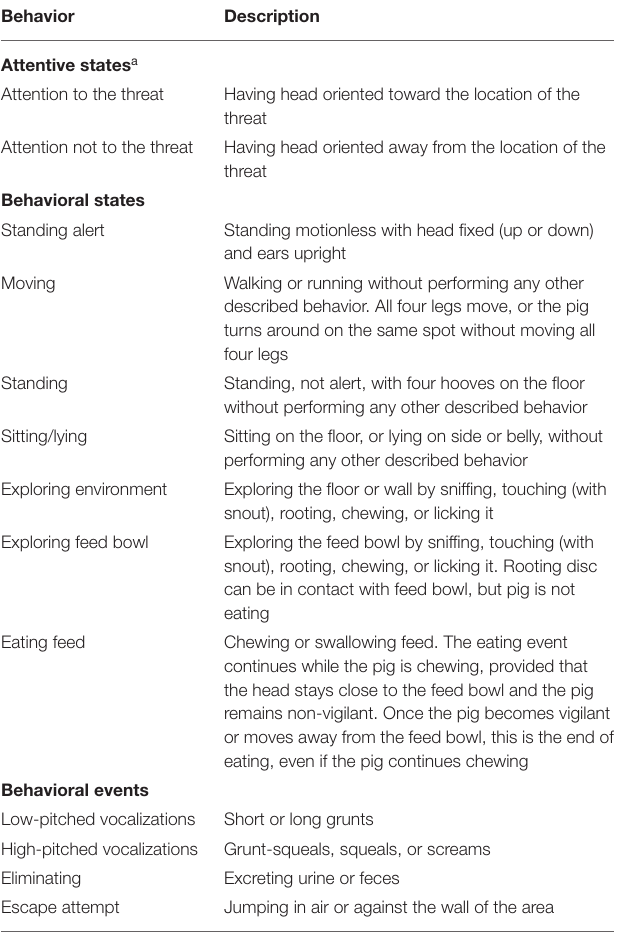
TABLE 3 | Ethogram of behaviors observed during the novel environment test and the attention bias test.